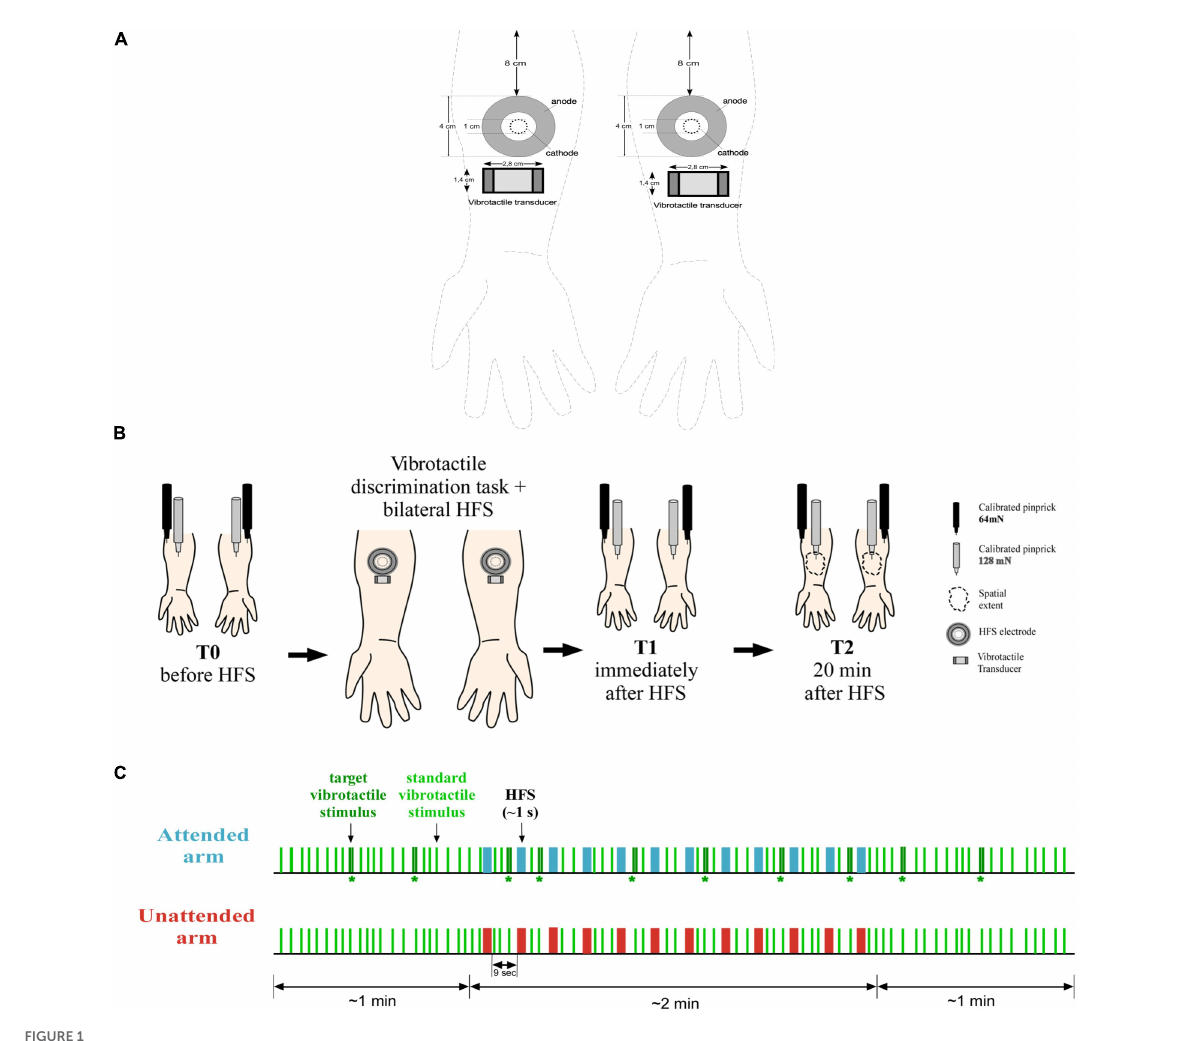
FIGURE1 Materials and method. (A) HFS was delivered on both arms using two electrodes consisted of 16 blunt stainless-steel pins placed in 10-mm diameter circle (cathode), surrounded by a stainless-steel circular anode. The vibrotactile transducer was placed on the skin immediately below the electrode (ca. 2 cm). Experimental procedure. (B) On both forearms, mechanical pinprick sensitivity was measured with two different intensity of pinprick stimulation (128 and 64 mN), before the simultaneous and bilateral delivery of HFS in combination with the detection task (T0), immediately after (T1), and 20 min later (T2). In addition, at time T2, the extent of the area of increased sensitivity was measured along the medial-later and the proximal-distal axes. Manipulation (C) 93 standard vibrotactile stimuli (a single 20-ms vibration) were